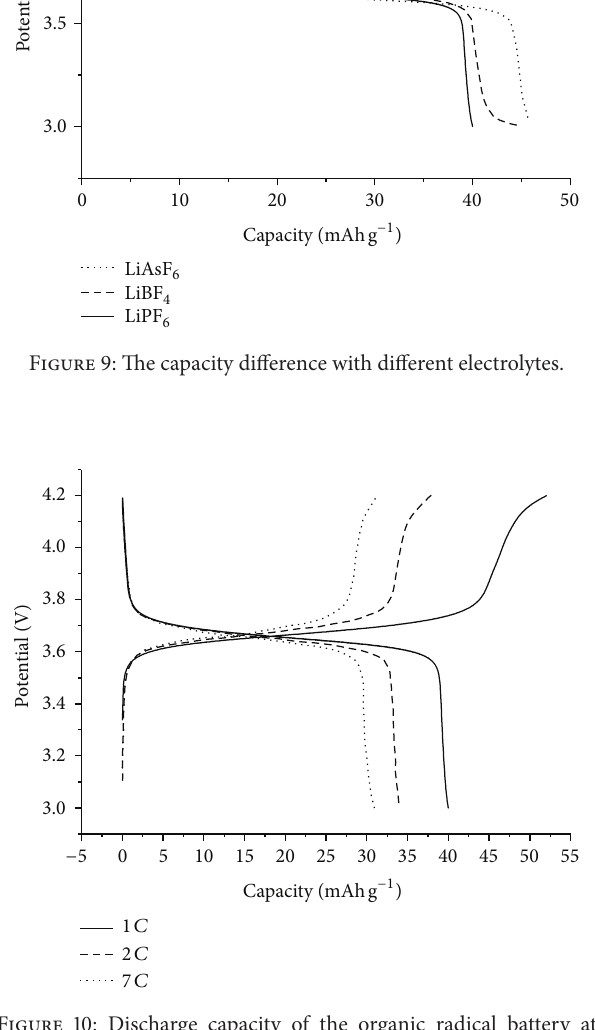
Figure 10: Discharge capacity of the organic radical battery at different C